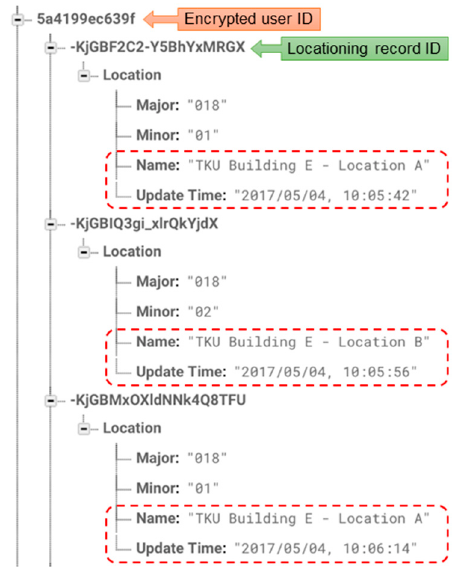
Figure 11. A snapshot of the Firebase database showing the moving pattern of a user.